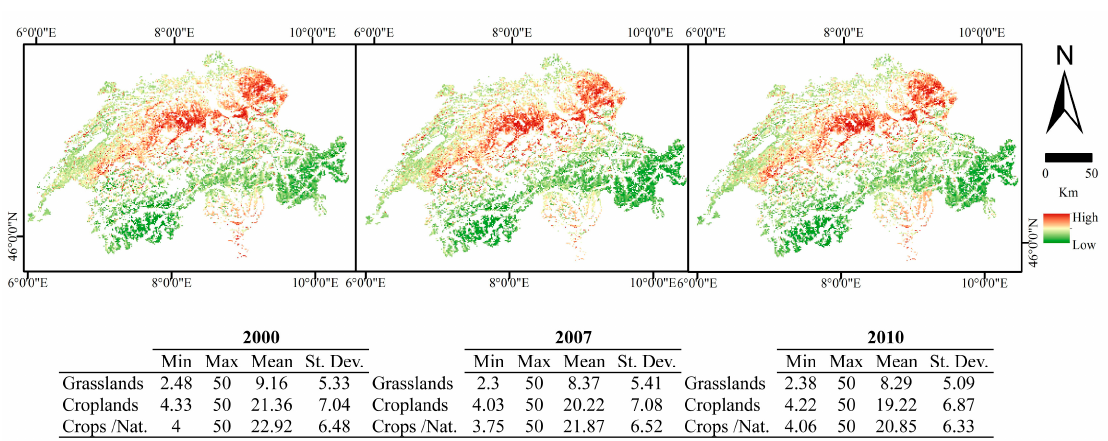
Figure A2. Spatial variability of yearly-accumulated precipitation: (a–c) croplands (455–3490 mm/year), croplands/natural vegetation mosaic (469–3472 mm/year), and grasslands (534–3825